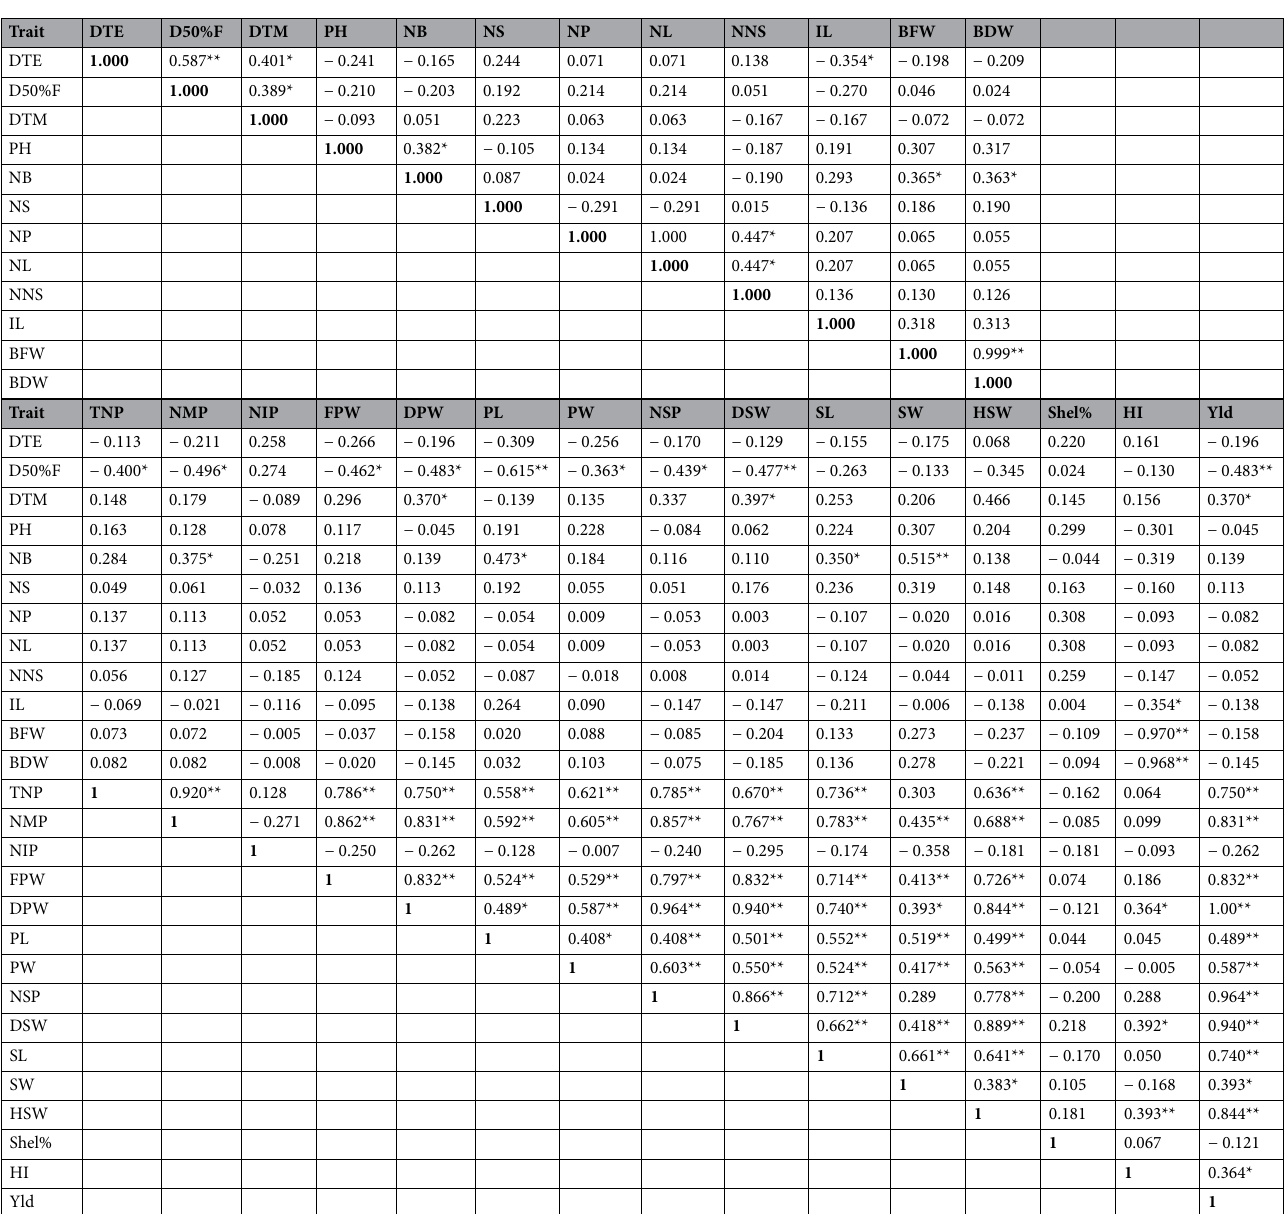
Table 8. Pearson’s correlation (r) estimates for 27 phenotypes of 30 accessions of Bambara groundnut. “**”correlation is significant at the 0.01 level; “*” correlation is significant at the 0.05 level, Days to emergence = DTE (d), Days to 50% flowering (d), DTM Days to maturity (d), PH Plant height (cm), NB Number of branches per plant, NS Number of stems per plant, NP Number of petioles per plant, NL Number of leaves per plant, NNS No. of nodes per stem, IL Inter nodes length (cm), BFW Biomass fresh weight per plant (g), BDW Biomass dry weight per plant (g), TNP Total no. of pods per plant, NMP Number of mature pods per plant, NIP Number of Immature pods per plant, FPW Fresh pods weight (g), DPW Dry pods weight (g), PL Pod length (mm), PW Pod width (mm), NSP Number of seeds per plant, DSW Dry seed weight